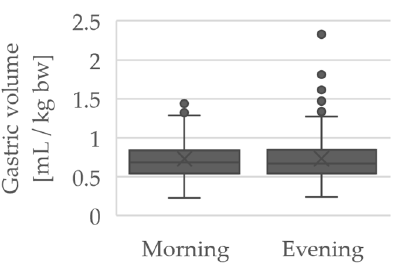
Figure 3. Boxplots of the GRV in mL/kg bw for the morning and evening measurements.